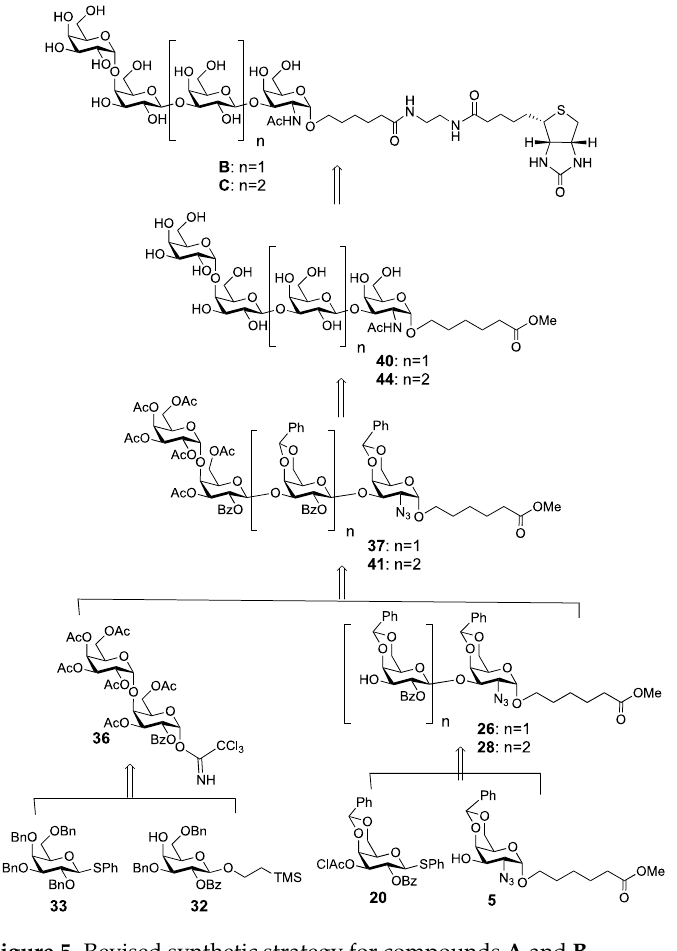
Scheme 6. Preparation of pentasaccharide derivative 31 .